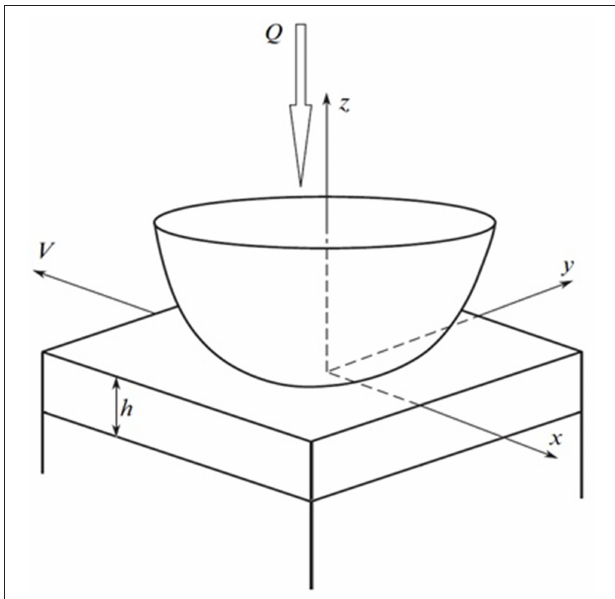
FIGURE 1 | Scheme of